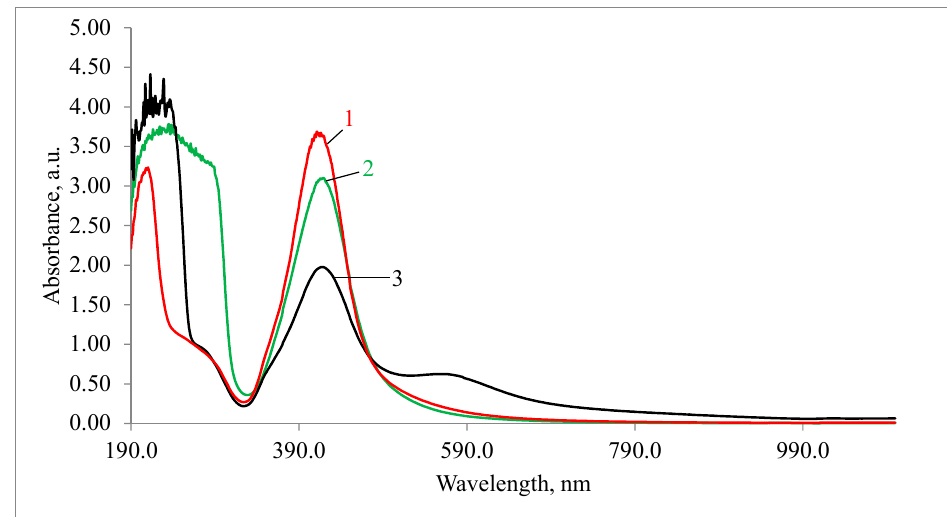
Figure 4. Absorption spectra of a silver nanoparticles suspension: 1, initial suspension; 2, albumin ‐ coated silver nanoparticles; 3, polysorbate ‐ 80 ‐ coated silver nanoparticles.